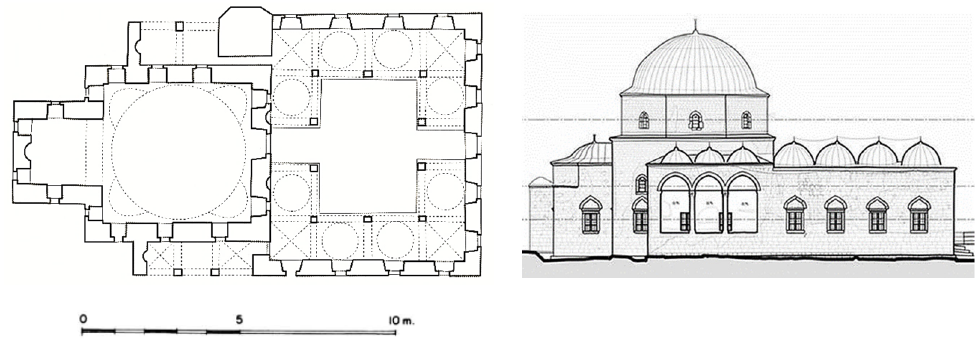
Figure 11. Plan layout ( left ) and elevation ( right ) of the Lead Mosque in Shkodra. Provision courtesy from Arch. Arsim Murseli, UBT University, Pristina, Kosovo.